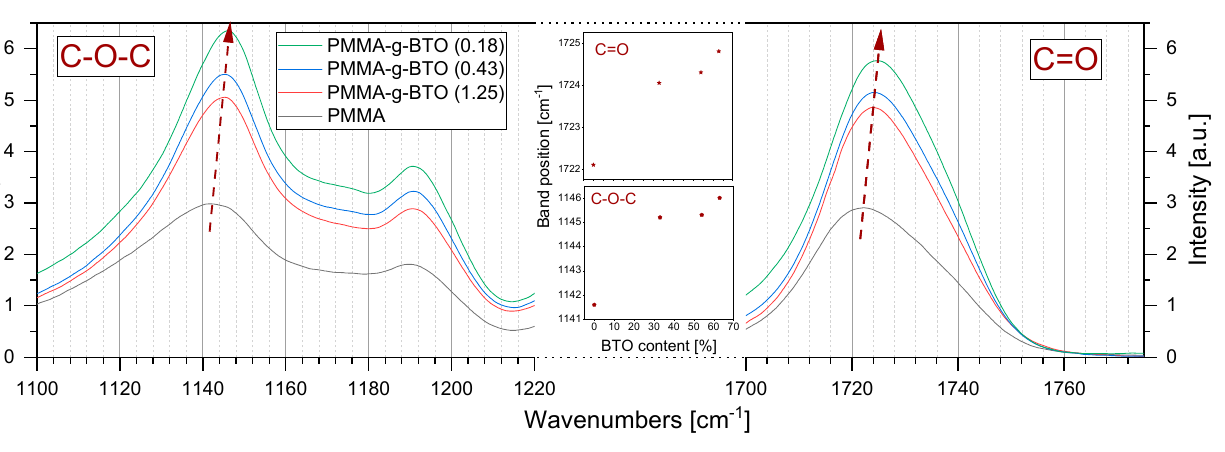
Figure 8. ATR FT-IR spectra of PMMA- g -BTO nanocomposites at the regions of C=O and C–O–C stretching vibrations. All spectra were normalized to the intensity (signal amplitude) of the line with a maximum at 750 cm − 1 . Inset in the middle part of the chart shows changes in the positions of the characteristic line maxima vs. BTO percentage.